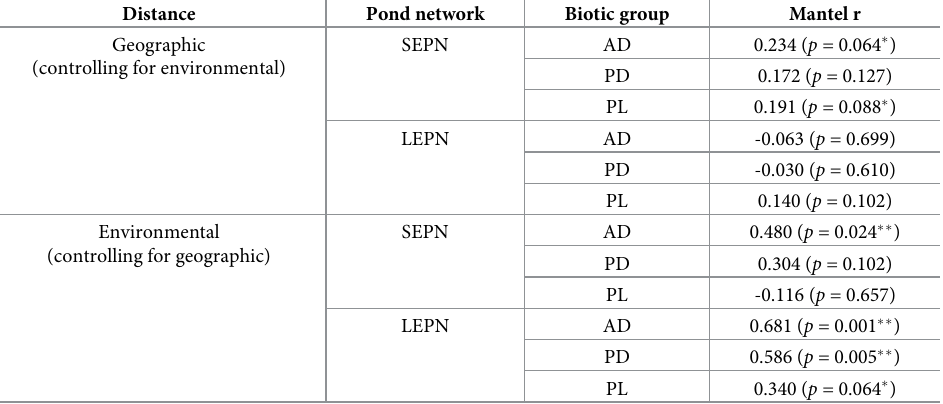
Statistical significance for each partial Mantel correlation value is given in parentheses. Abbreviations are